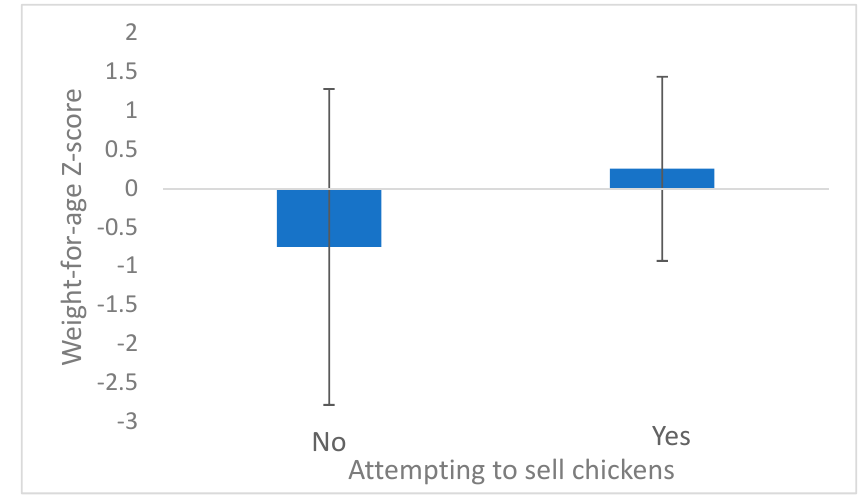
Figure 3. Weight-for-age z-scores for households that attempted to sell chickens and households that did not ( p = 0.004).